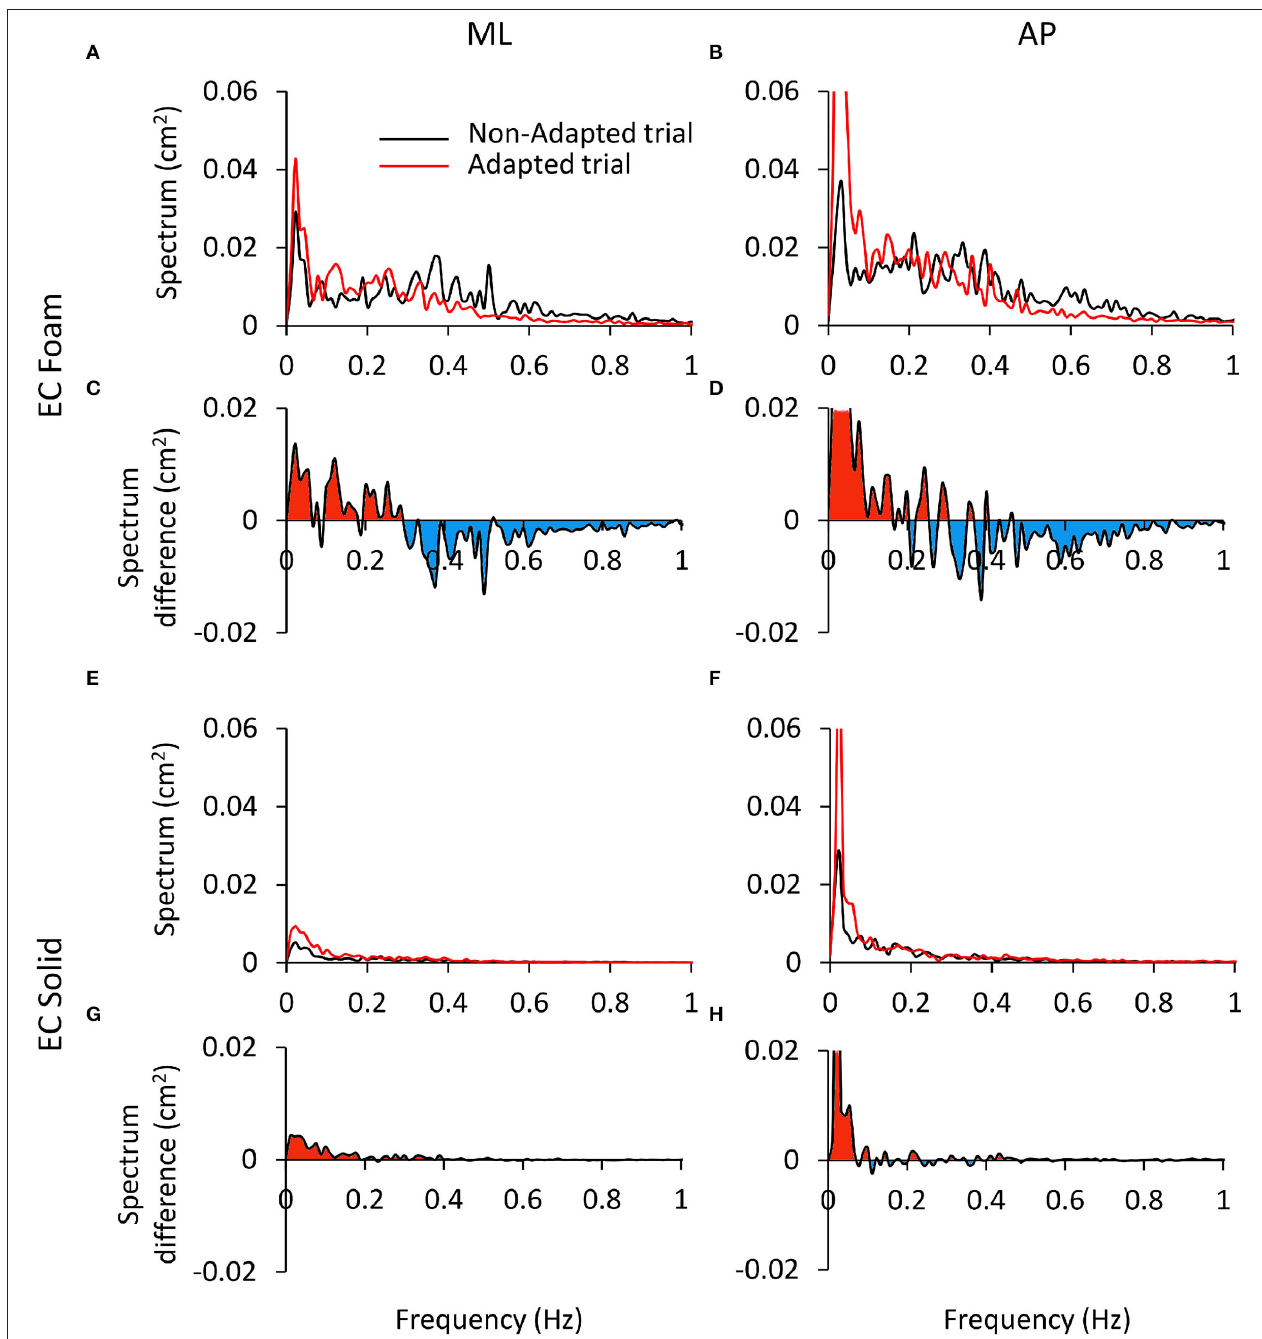
FIGURE 8 | Differences in the power spectrum between the non-adapted and adapted trials. (A–D) refer to EC Foam, (E–H) to EC Solid condition. In (A,B,E,F) the mean Spectrum profiles of the non-adapted (black) and adapted trials (red) are reported for ML (A and E) and AP directions (B,F) . In (C,D,G,H) , the difference (adapted minus non-adapted) between the spectrum profiles of the non-adapted and adapted trials is shown. Red areas indicate a larger amplitude of the spectrum in the adapted than the non-adapted trial, oppositely the blue areas. With adaptation, the Spectrum Level increases at low frequencies ( < 0.3Hz) and decreases at high frequencies ( > 0.3Hz). This effect is limited to the low frequency range on a Solid support. The ordinates are capped in all the panels.